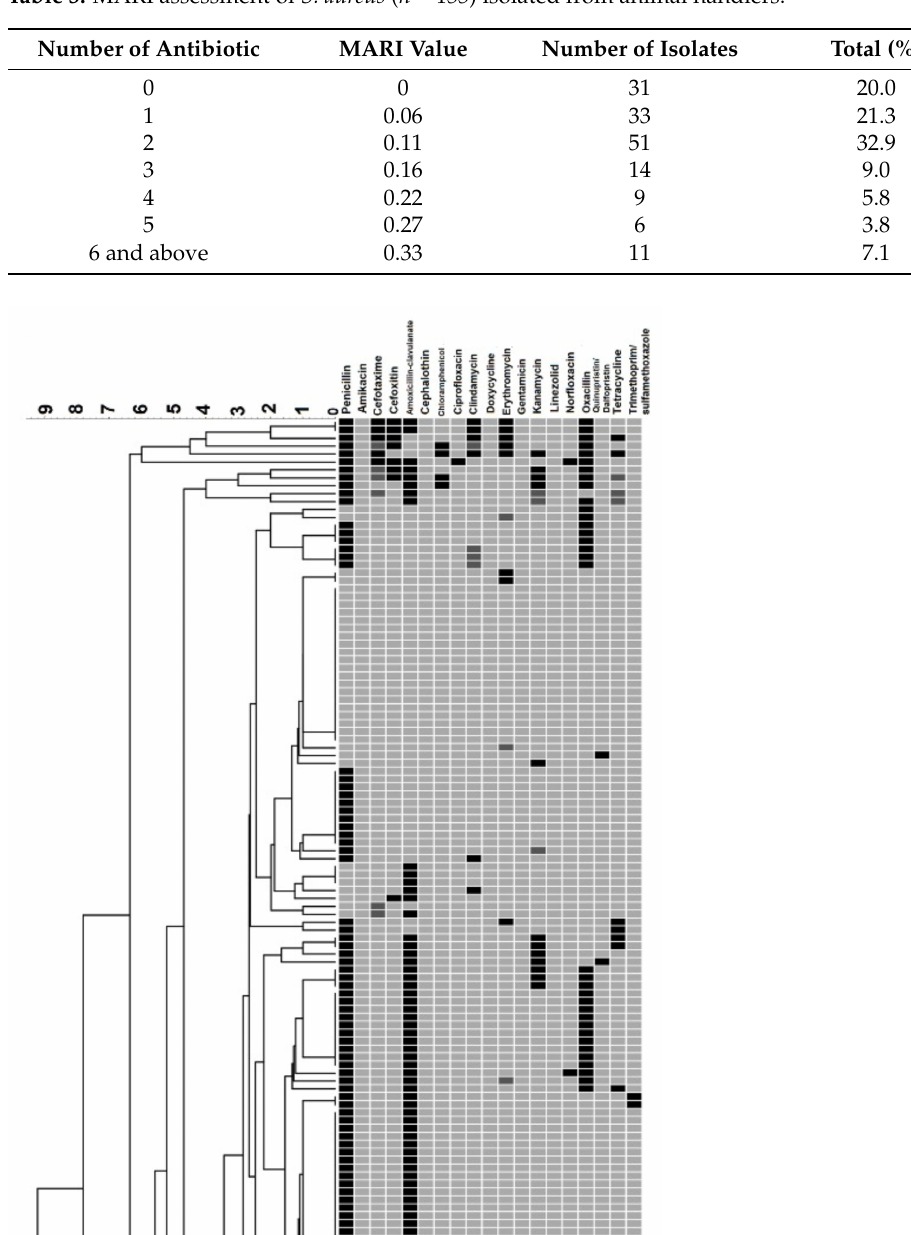
Table 3. MARI assessment of S. aureus ( n = 155) isolated from animal handlers.